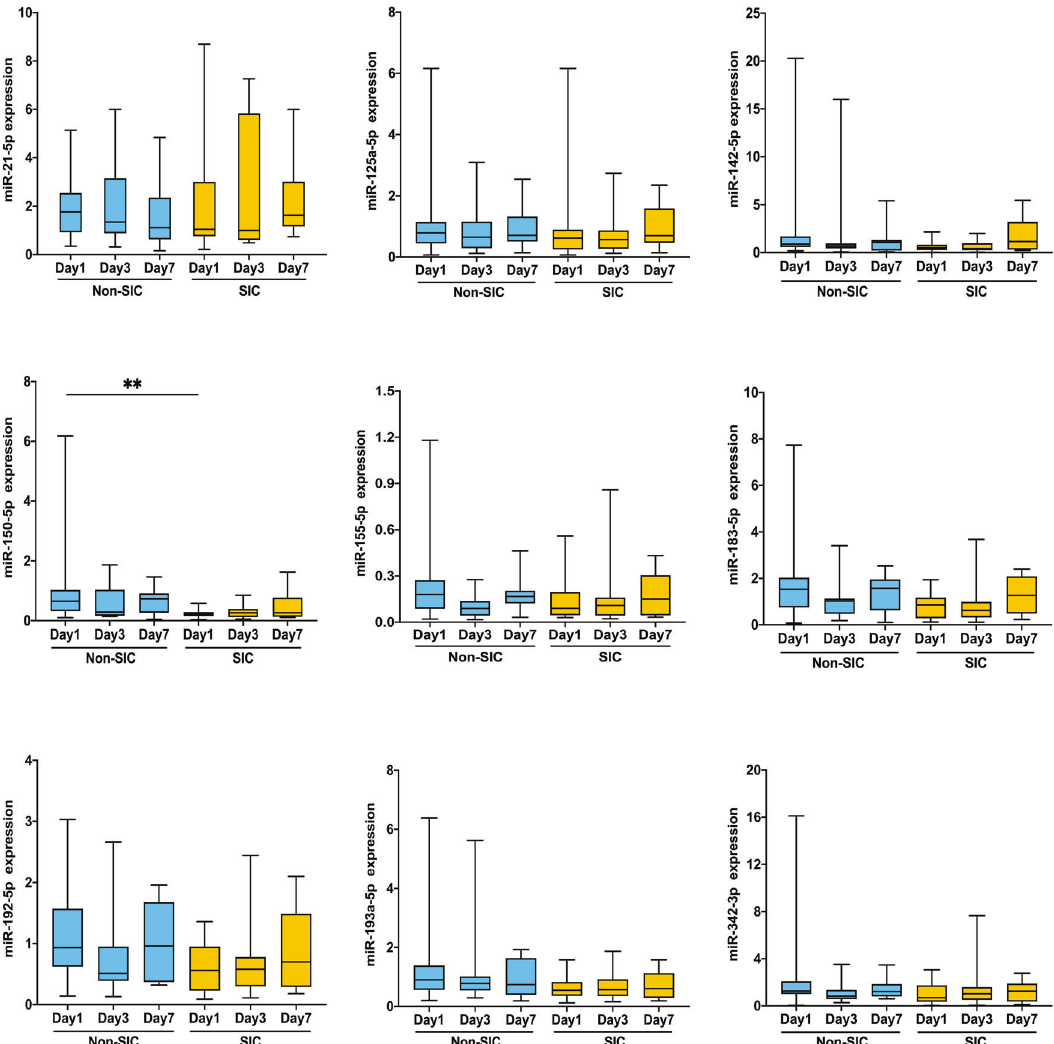
Fig. 3 Validation of candidate miRNAs in neutrophil-derived EVs in an independent cohort by qRT-PCR. Non-SIC ( n = 30) and SIC ( n = 20); * p < 0.05, ** p <